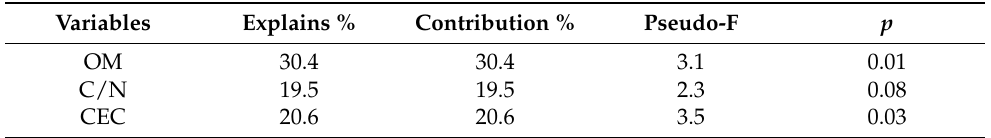
Table 4. Significance of explanatory variables for functional macrofungal compositions based